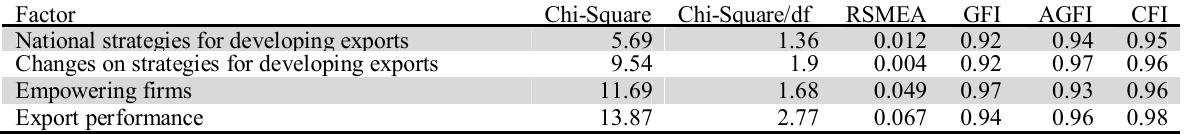
The summary of statistical observations Factor Chi-Square Chi-Square/df RSMEA GFI CFI National strategies for developing exports Empowering